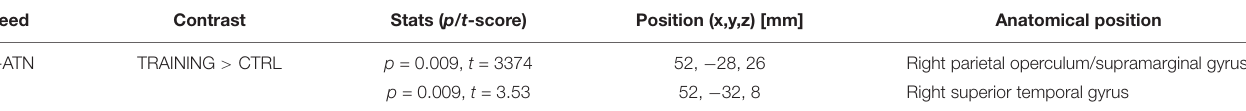
TABLE 4 | Summary of score-whole-brain (SWB) analysis from R-ATN seed: group × nogo hits significant